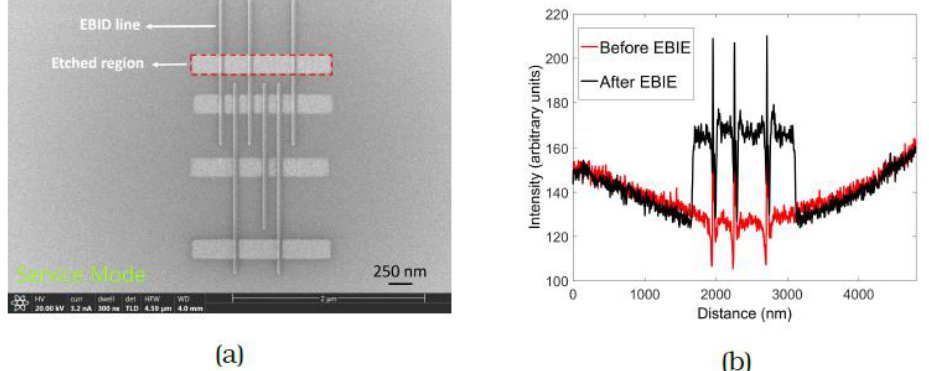
Figure 3. ( a ) SE image of array of carbon FEBID lines after large area cleaning. The red dashed rectangle indicates a typical etched region. Four regions containing lines of spacing 150 nm, 300 nm and 450 nm were etched for a time of 7 s each. ( b ) Integrated intensity plot of topmost region before focused electron beam-induced etching (FEBIE) (red) and after FEBIE (black). The increase in SE signal observed in between the lines demonstrates the removal of carbon and the extent of this region corresponds with the exposed area.